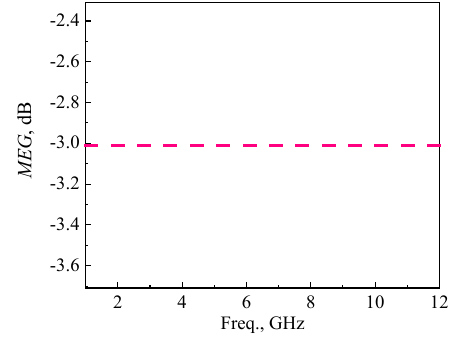
Fig. 15. MEG of the MIMO